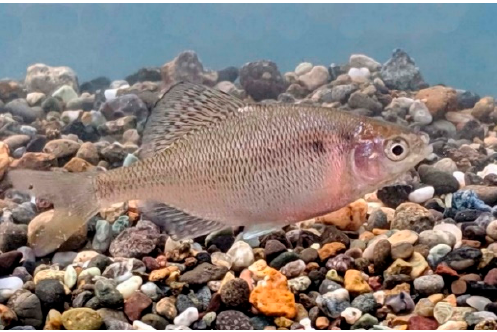
Figure 1. Map of the northern part of Honshu Island, Japan, showing collecting localities for Acheilignathus typus in the present (star) and previous [13] studies. The solid circle indicates a pond in Kashimadai with haplotypes identical to those from northern Niigata. Other known localities are indicated by open circles. Mountain ranges dividing watersheds are indicated by Λ . Dark gray areas contain present-day known localities, whereas areas in light gray indicate past distribution ranges.